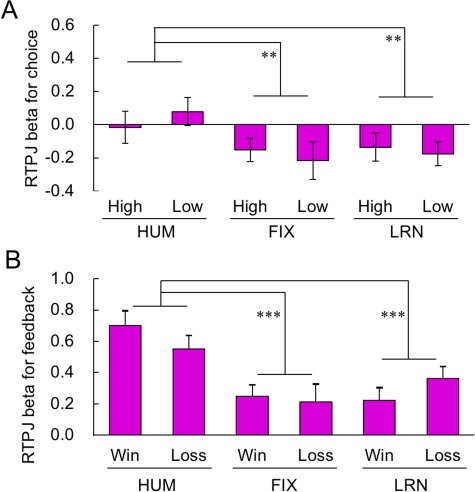
Imaging results for RTPJ. A. The activation of RTPJ in the choice phase. Although the overall activation was not statistically distinguishable from zero (see Figure 4B), the main effect of opponent was significant by a two-way repeated measures ANOVA over opponent (HUM/FIX/LRN) × choice (high/low): RTPJ activation was significantly higher in HUM than in FIX and LRN conditions. B. Activation of RTPJ in the feedback phase. RTPJ activation was significantly higher in the HUM condition than in the FIX and LRN conditions. The asterisks indicate statistical significance (**P < 0.01, ***P < 0.001).